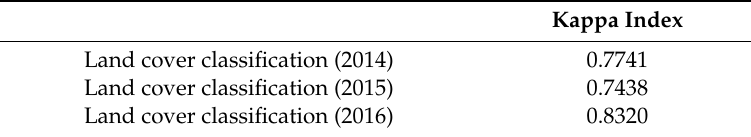
Table 4. Cohen’s Kappa index for 2014, 2015, and 2016 land cover classifications.